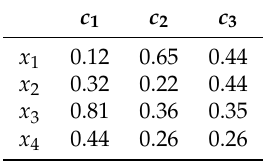
Table 10. R 2 : opinion of expert m 2